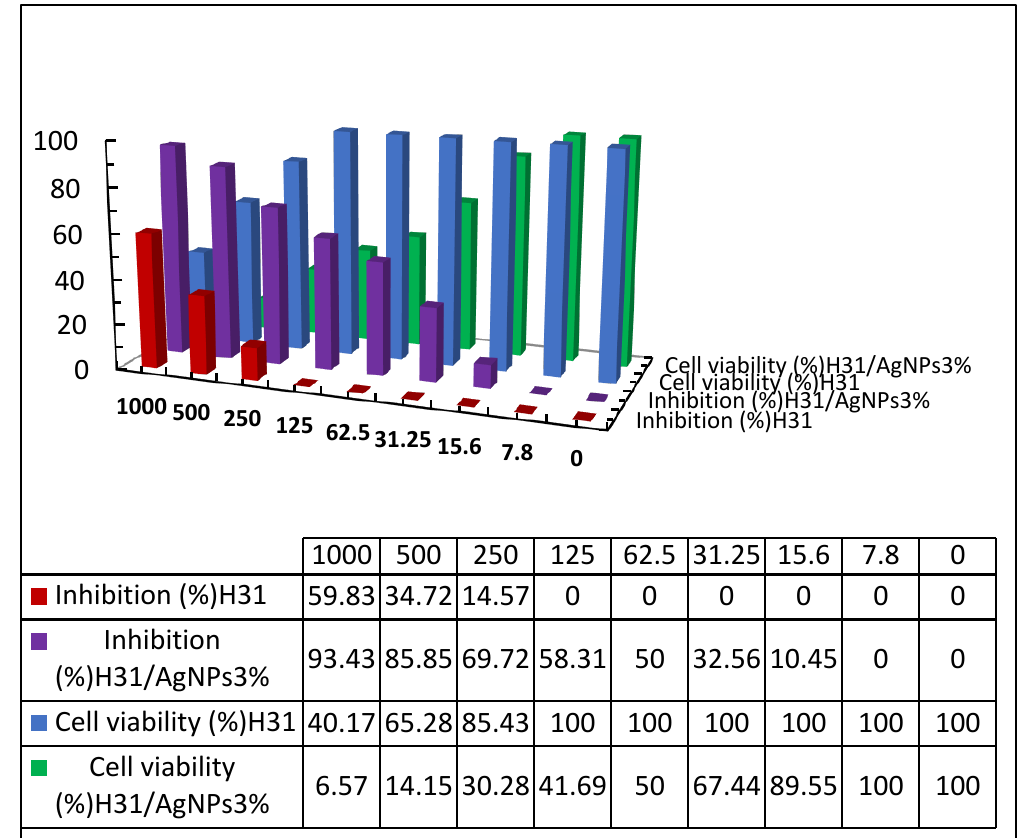
Figure 13. Cytotoxicity inhibitory effect of H 31 and H 31 /AgNP3% against normal human lung fi- broblast cells.